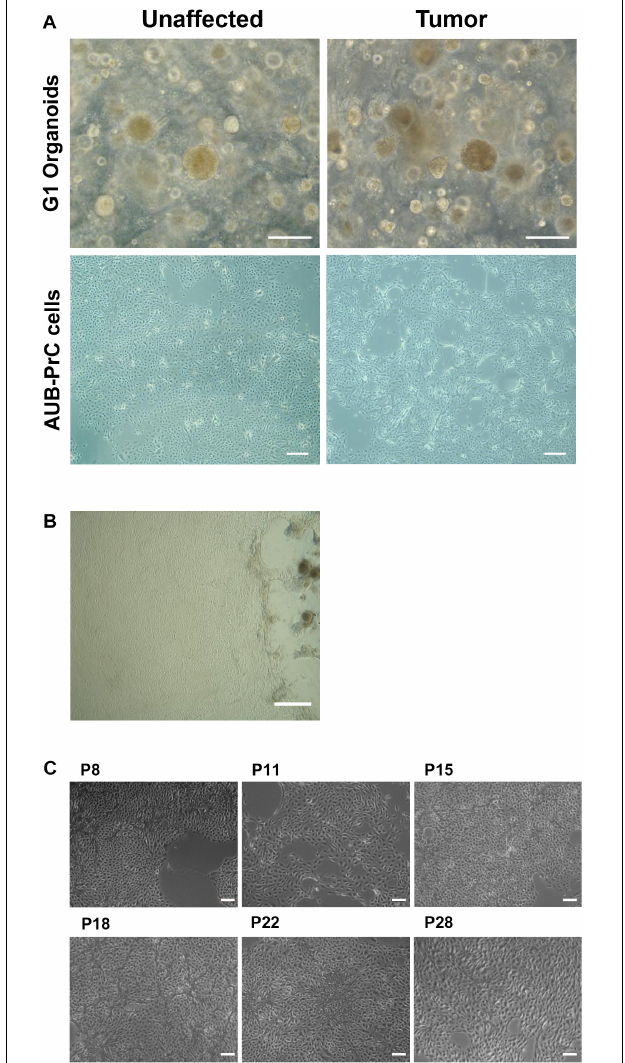
FIGURE 1 | Isolation of patient-derived AUB-PrC cells using organoids culture conditions. Representative bright-field images showing established prostate organoids (generation 1, G1) from unaffected and tumor prostate patient samples {patient 2 with Grade Group 3 [Gleason Score 7(4 + 3)]; patient characteristics in Supplementary Table S1 } grown in culture (Scale bar = 200 µ m) (A) , and AUB-PrC cells established and grown on 1% collagen type-I coated plates (Scale bar = 200 µ m) (B) maintaining their healthy morphology when propagated for continuous passages (passages P8, P11, P15, P18, P22, and P28 are shown) reaching more than 28 passages with successful repeated freeze-thaw cycles (Scale bar = 100 µ m) (C)